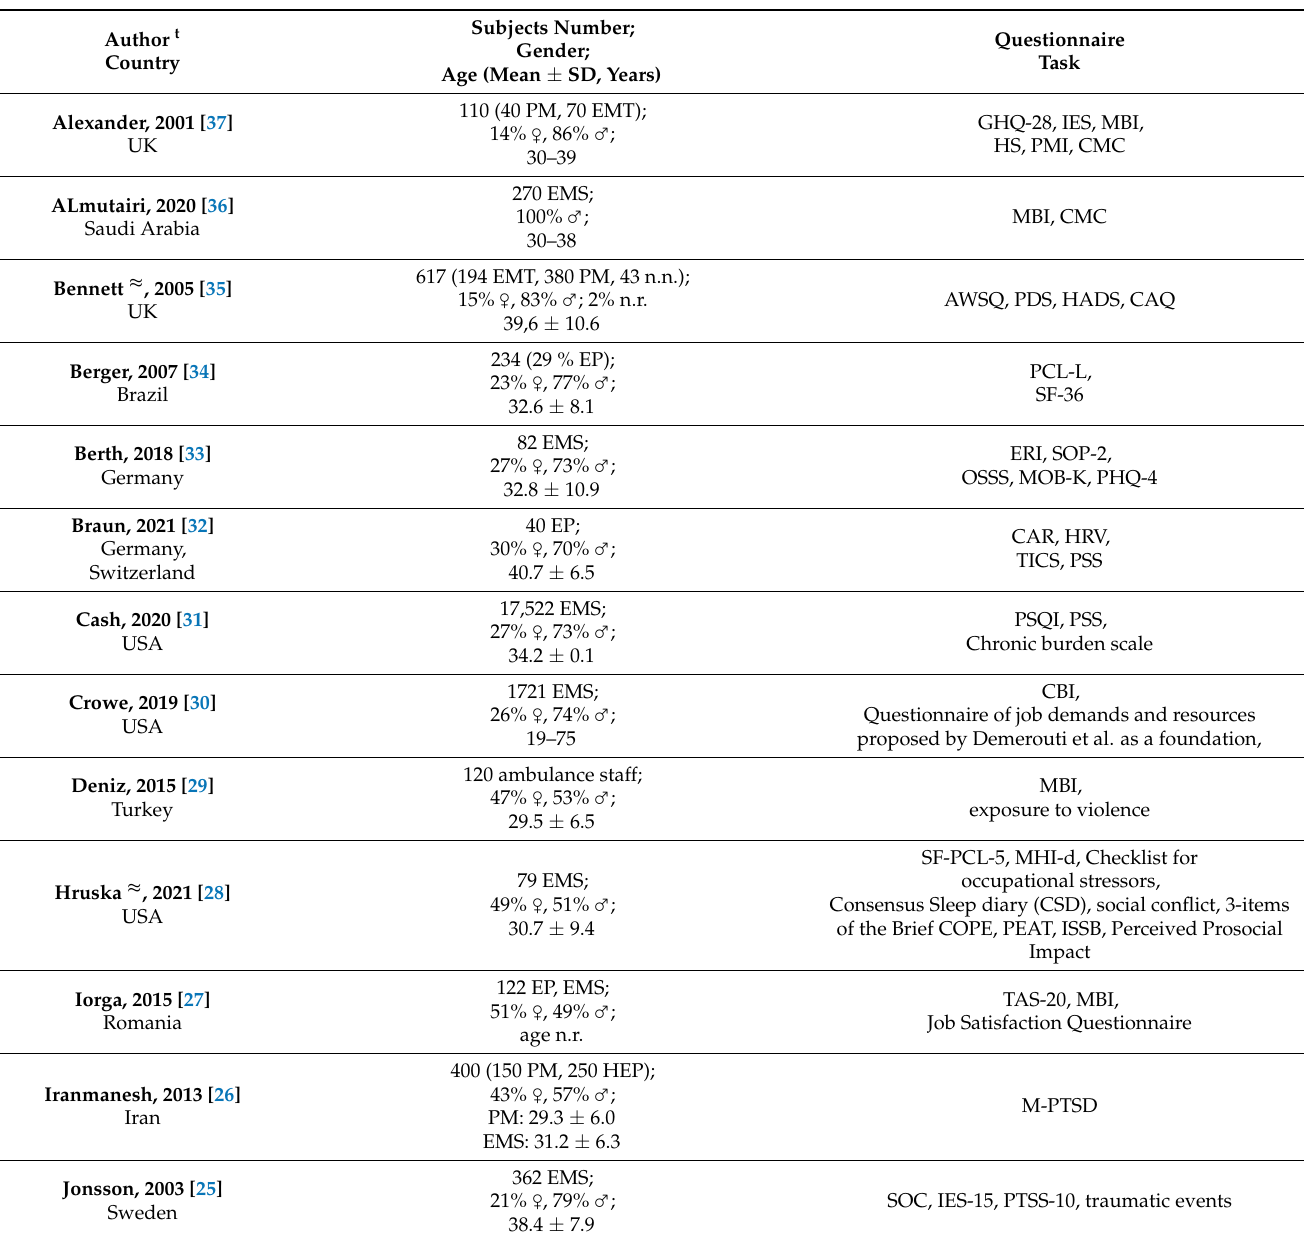
Table 2. An overview of the included studies with the thematic of stress and strain (the results are shown in Supplementary File